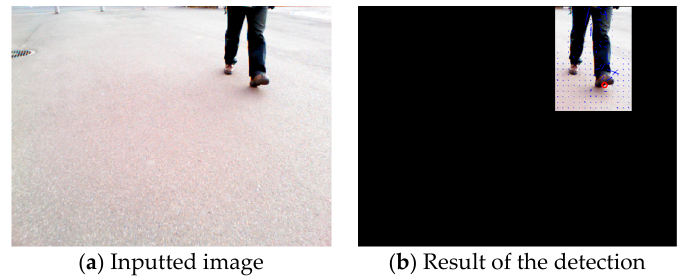
Figure 19. Example of the dynamic hazardous object detection by optical flow.